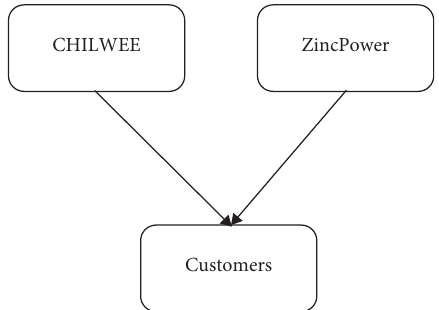
Figure 1: Supply chain analysis of zinc-nickel battery market.